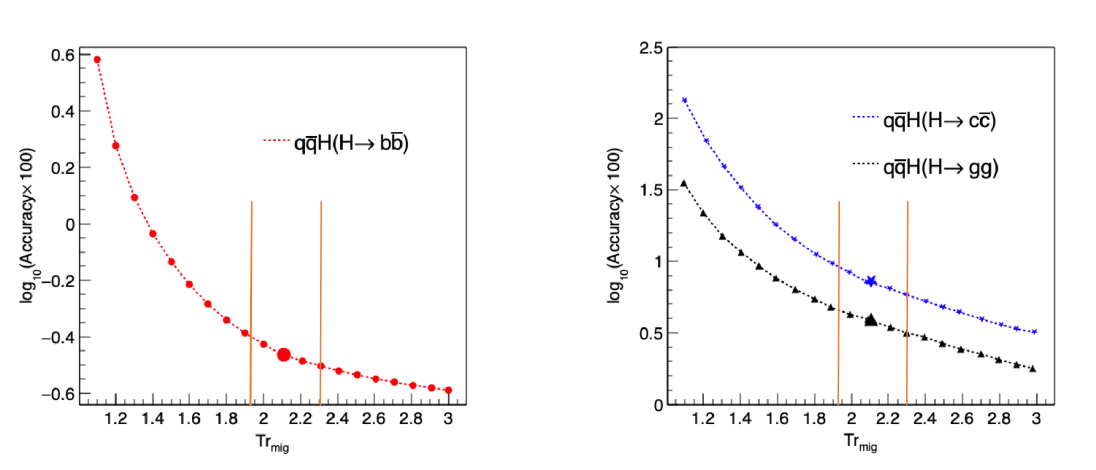
¯ Figure 12 . The dependence of q ¯ qH ( H → b b/c ¯ c/gg ) signal strength accuracy on flavor tagging performance is shown in this figure, the left plot is for q ¯ qH ( H → b ¯ b ) , and the right plot is for q ¯ qH ( H → c ¯ c/gg ) . The bigger markers correspond to the results of the CEPC baseline detector. When the key vertex detector parameters, including inner radius, material budget, and spatial res- olution, are changed by a factor 0.5/2 from the baseline design, the Tr value changes accordingly mig from 2.12 to 2.31/1.93, shown as two vertical orange lines.